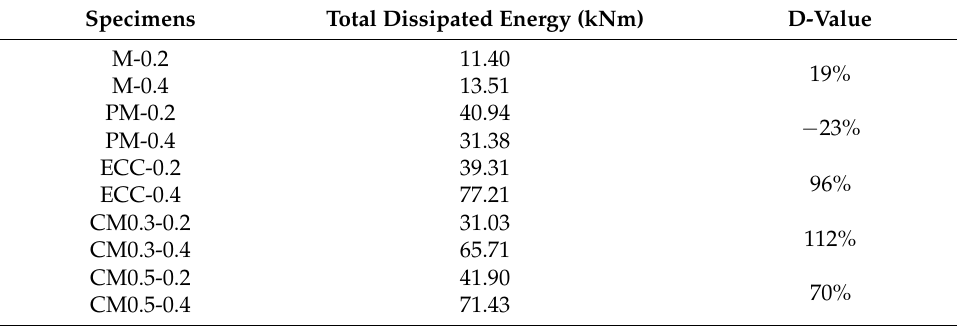
Figure 18. Failure mechanism of mortar joint before peak load (stages I and II).